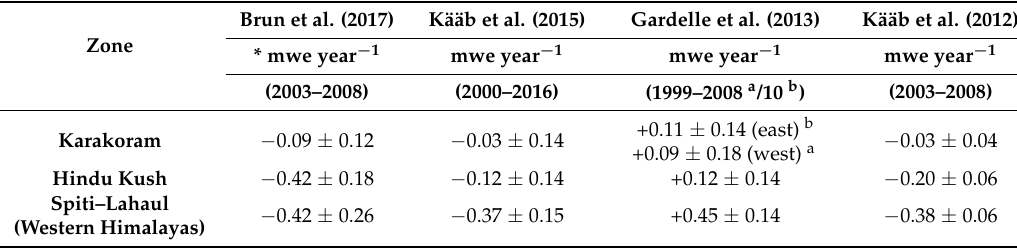
Figure 2. Snow cover change over four catchments in UIB from 2002 to 2010 (based on Reference [89]). Table 4. Estimated glacier mass balances (mwe y –1 ) in the published literature for different UIB regions and overlapping study periods.